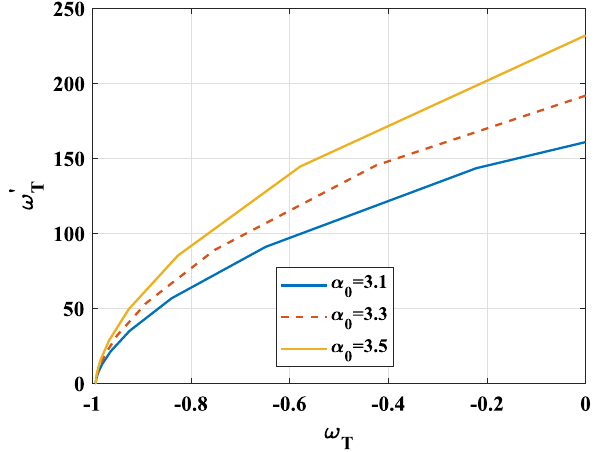
Fig. 7 Plot of EoS parameter ( ω T ) versus time ( t ) for k = 1 . 9, α 1 =